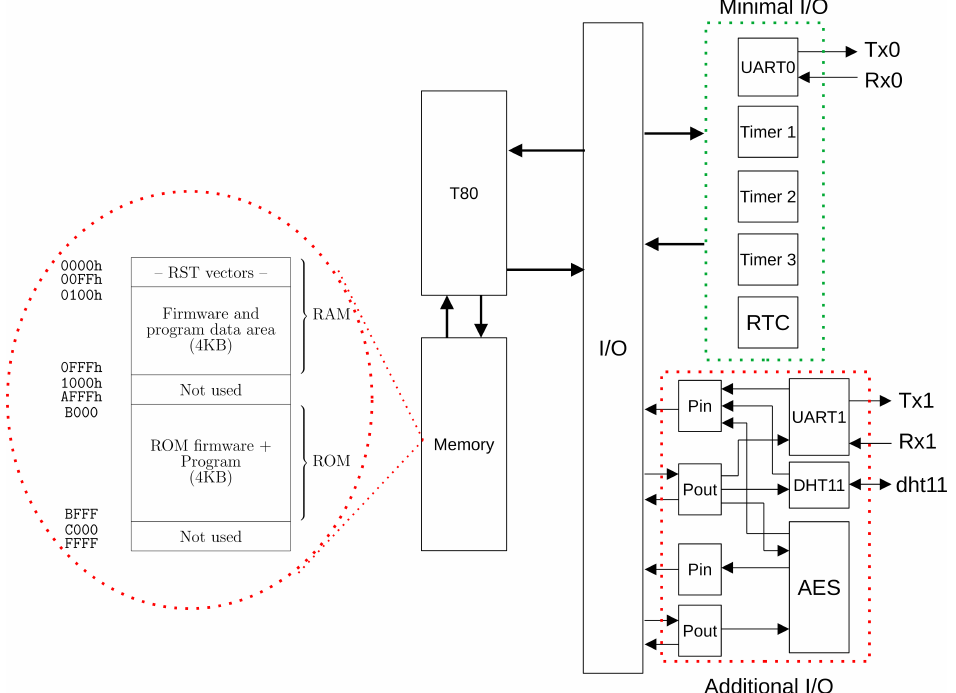
Figure 16. Dracon for building a completely embedded IoT device with hardware AES